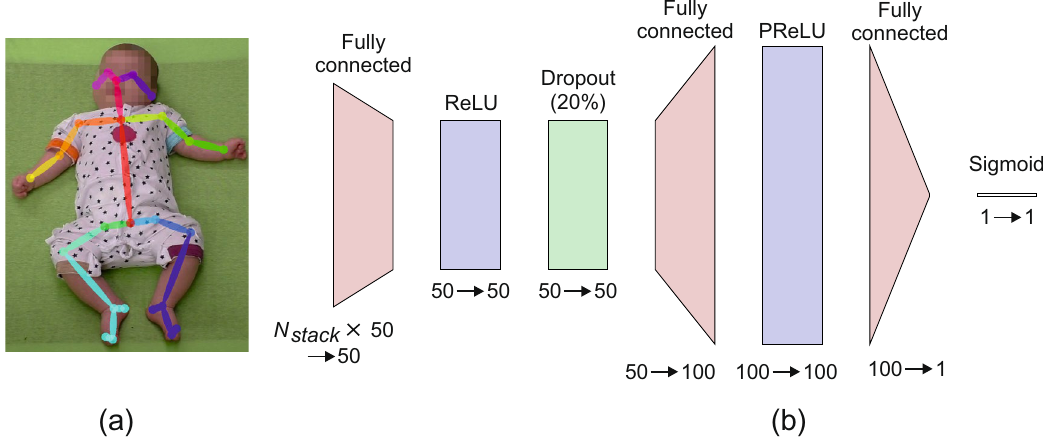
Figure 3. ( a ) An example frame with 25-point skeleton overlay and ( b ) a schematic diagram of the SMNN 5 network architecture.